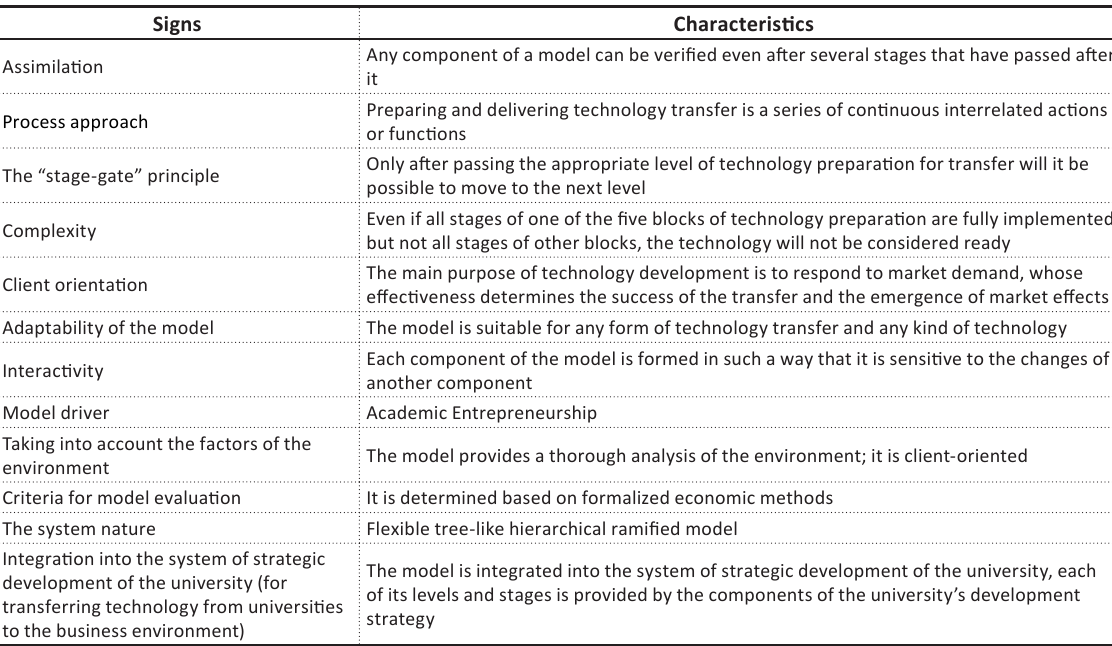
Table 1. Characteristics of the technology transferability evaluation